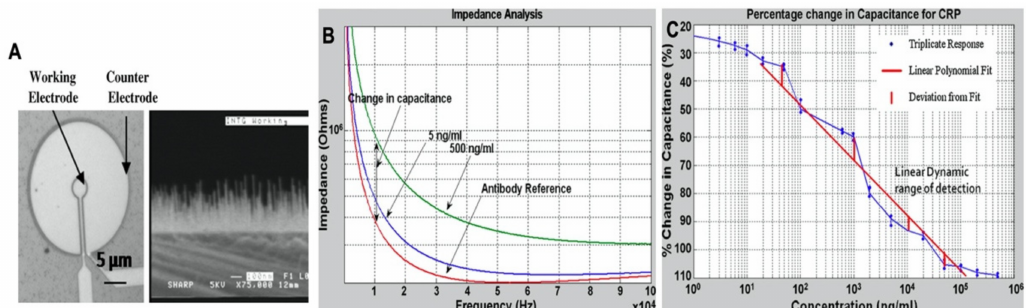
Figure 20. ( A ) Image of protein sensing area and Iridium oxide nanowires. ( B ) The impedance analysis of different concentrations of CRP and corresponding concentration vs. change of the capacitance (%) relationship ( C ). Reprinted with permission from references [75]. Copyright 2009 Elsevier